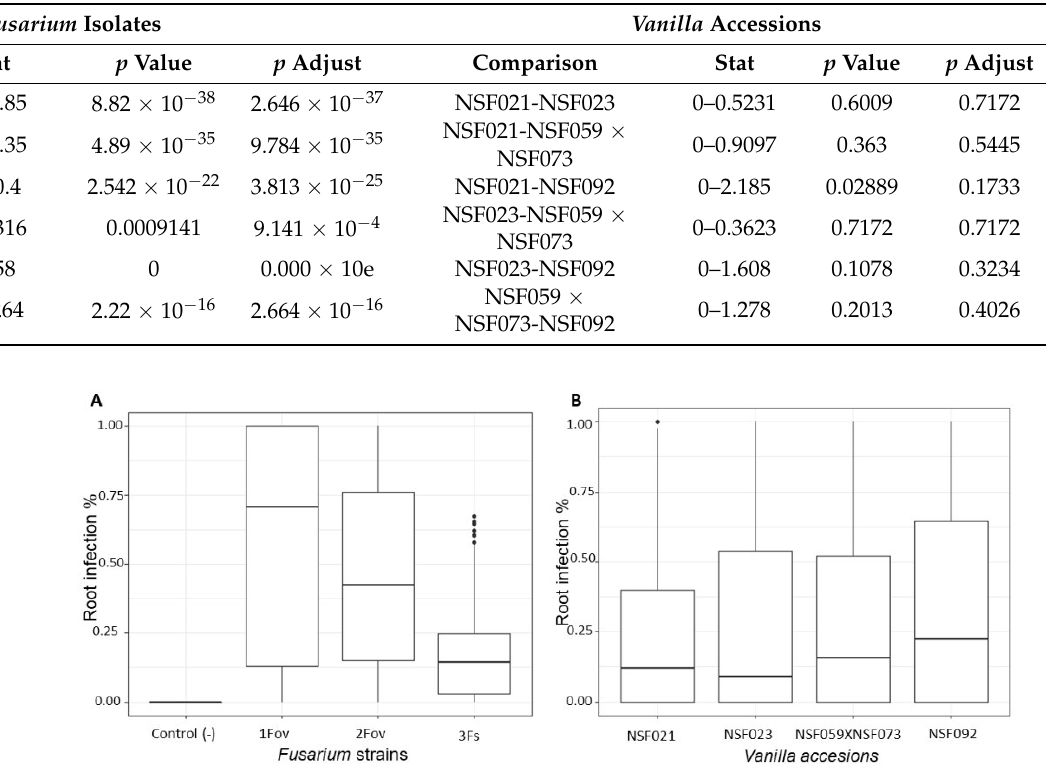
Table 2. Multiple comparisons of means with Bonferroni correction to detect statistical differences within each design factor.